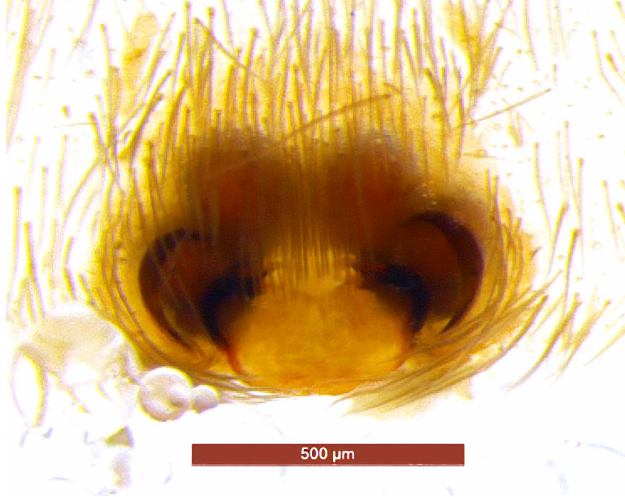
Figure 5. Drassodes omalosis , epigyne (FC: 8792).